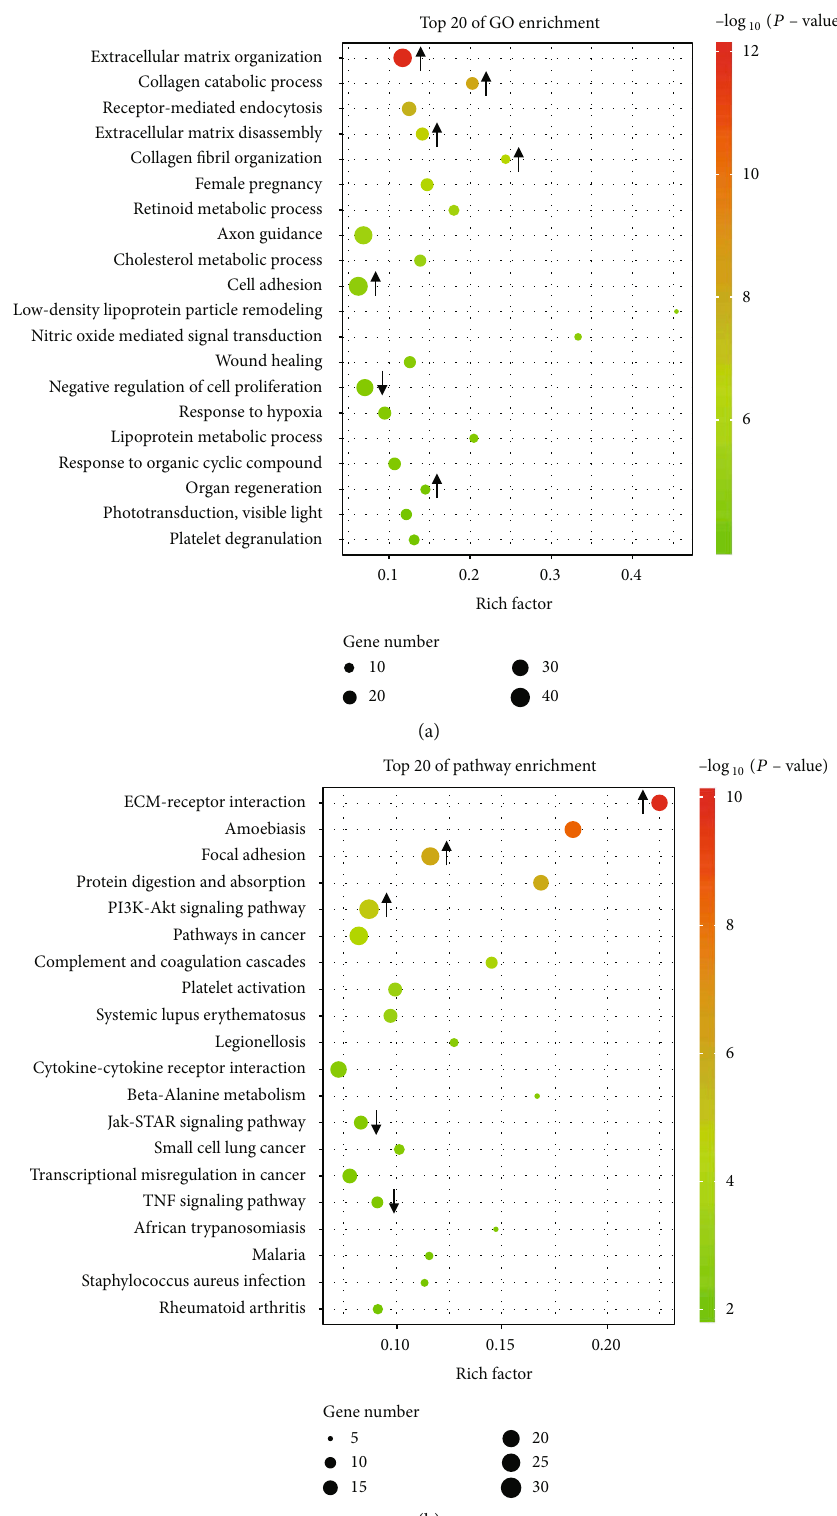
Figure 6: GO and pathway analysis of RNA-seq data. (a) Bubble diagram of the top 20 enriched GO terms of the di ff erentially expressed genes in HHIP-AS1-depleted PDLSCs. (b) Bubble diagram of the top 20 enriched pathway terms of the di ff erentially expressed genes in HHIP-AS1-depleted PDLSCs. The arrows mark the changes of key GO terms and signaling